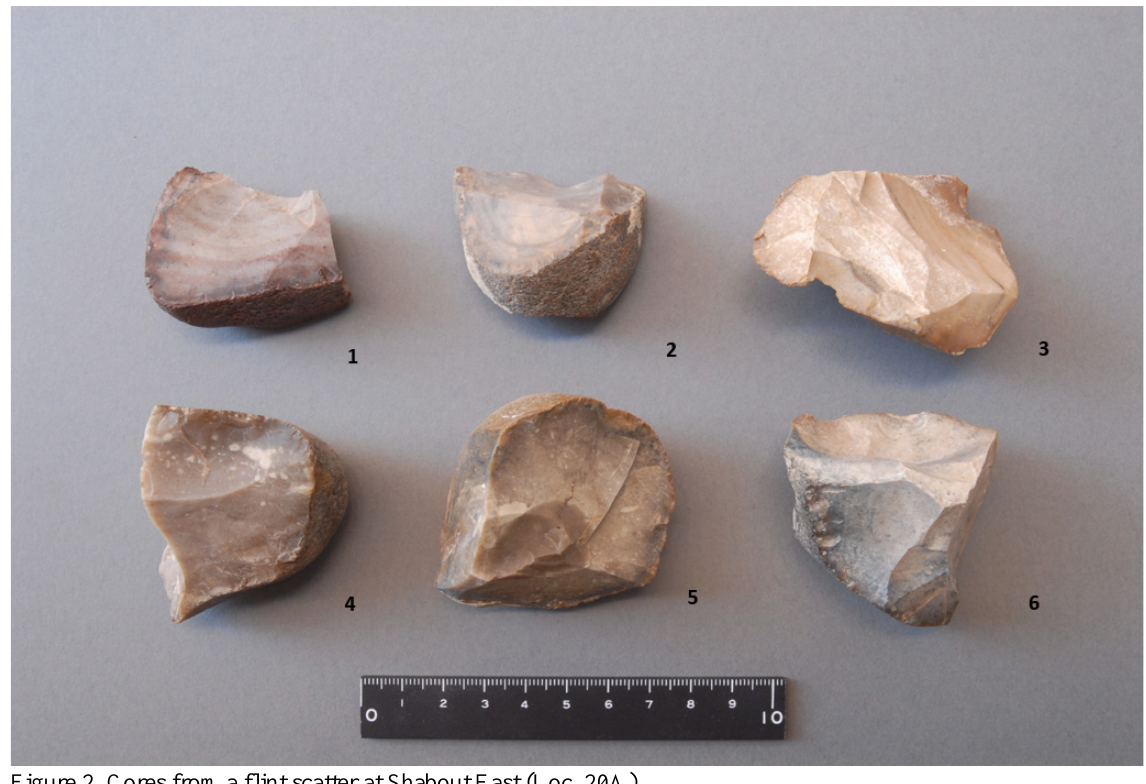
Figure 2. Cores from a flint scatter at Shabout East (Loc. 20A).